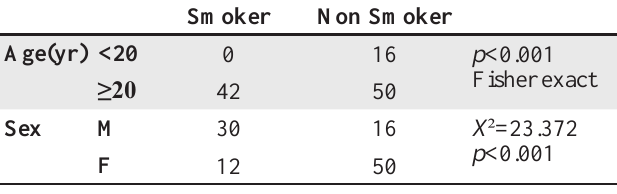
Table 2 : Relation of age and sex with cigarette smoking